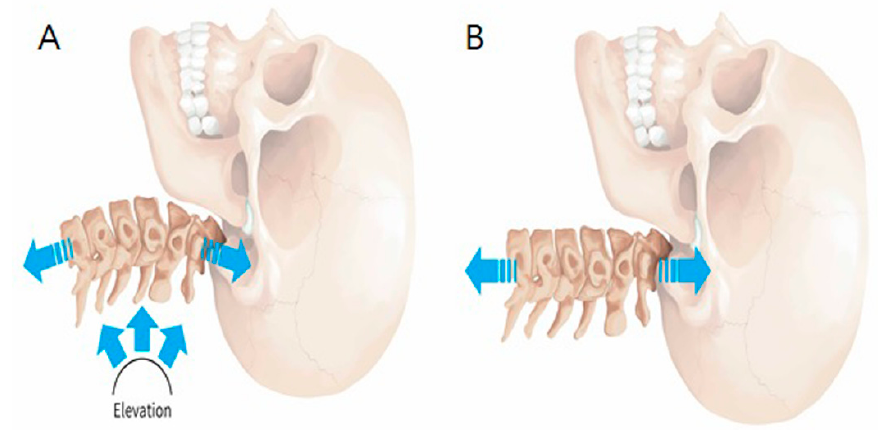
Figure 1. Technique of cervical traction: ( A ) cervical lordotic curve-controlled traction (C-LCCT) and ( B ) traditional traction (TT).